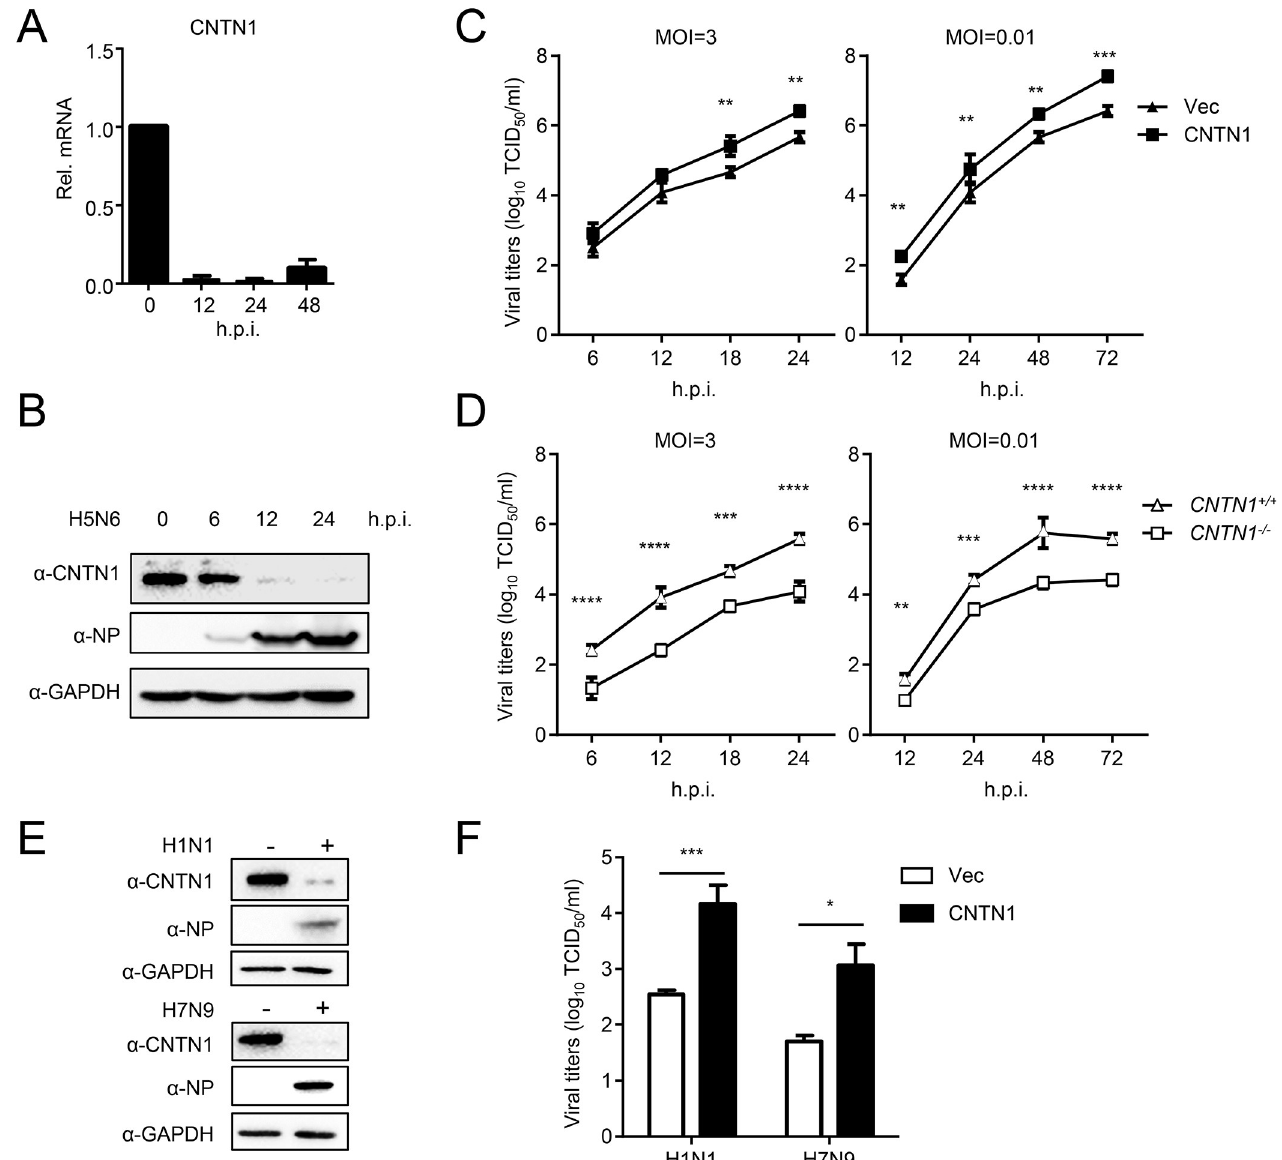
Fig 1. CNTN1 facilitates influenza A virus replication. (A) A549 cells were infected with H5N6 virus (MOI = 1), and the CNTN1 mRNA as quantified at different times post-infection by use of qPCR analysis. (B) A549 cells were infected with H5N6 virus (MOI = 1), and the expression level of CNTN1 protein was quantified at indicated times post-infection. (C) A549 cells were transfected with either the CNTN1 expression plasmid or empty vector (Vec). Twenty-four hours later, the cells were infected with H5N6 virus at an MOI of 0.01 or 3. At the indicated times post-infection, the supernatant containing viral particles was assessed in the TCID 50 assay. (D) CNTN1 +/+ or CNTN1 -/- A549 cells were infected with H5N6 virus at an MOI of 0.01 or 3. At the indicated times post- infection, the supernatant containing viral particles was assessed in the TCID 50 assay. (E) A549 cells were infected with H1N1 or H7N9 virus (MOI = 1), and the expression level of CNTN1 protein was quantified at 24 h post-infection. (F) A549 cells were transfected with either the CNTN1 expression plasmid or Vec. Twenty-four hours later, the cells were infected with H1N1 or H7N9 virus at an MOI of 1. Twenty-four hours post infection, the supernatant containing viral particles was assessed in the TCID 50 assay. The data shown represent three independent experiments; bars represent the mean ± SD of the three independent experiments (n = 3). [ P < 0.05 ( � ), P < 0.01 ( �� ), P < 0.001 ( ��� ), P < 0.0001 ( ����